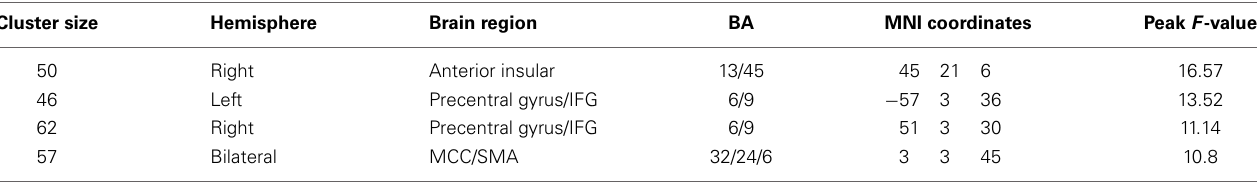
Table 4 | Main effect of the general risk propensity scores on the RSFC in the right IFG seed region.